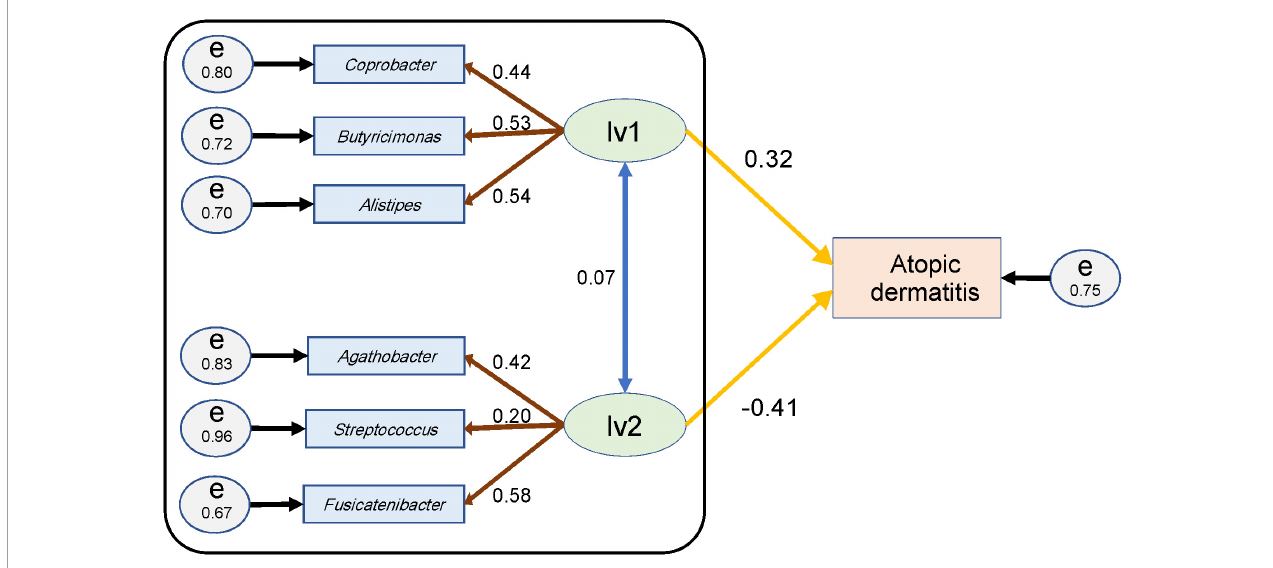
FIGURE3 Structural equation model for females and the parameter values. An ellipse (lv1 or lv2) represents a latent variable, and a rectangle (atopic dermatitis or genus name) represents an observed variable or indicators. Circles (e) represent the residual terms for each observed variable or indicator and the numerical value on the circle represents the residual variance. The numerical value of the double-headed blue arrow represents the correlation coefficient between the latent variables; that of the brown arrow represents the loading value from the latent variable to the indicator of the genera; and that of the yellow arrow represents the path coefficient from each latent variable to the observed variable for atopic dermatitis. The goodness-of-fit indices of this structural equation model were goodness-of-fit index (GFI) = 0.95, adjusted GFI (AGFI) = 0.85, and the root mean square error of approximation (RMSEA) = 0.06. The black framed part indicates the SEM portion that was used for estimating latent variable values in subsection (Section “3.4. Estimation of the latent variable values”).